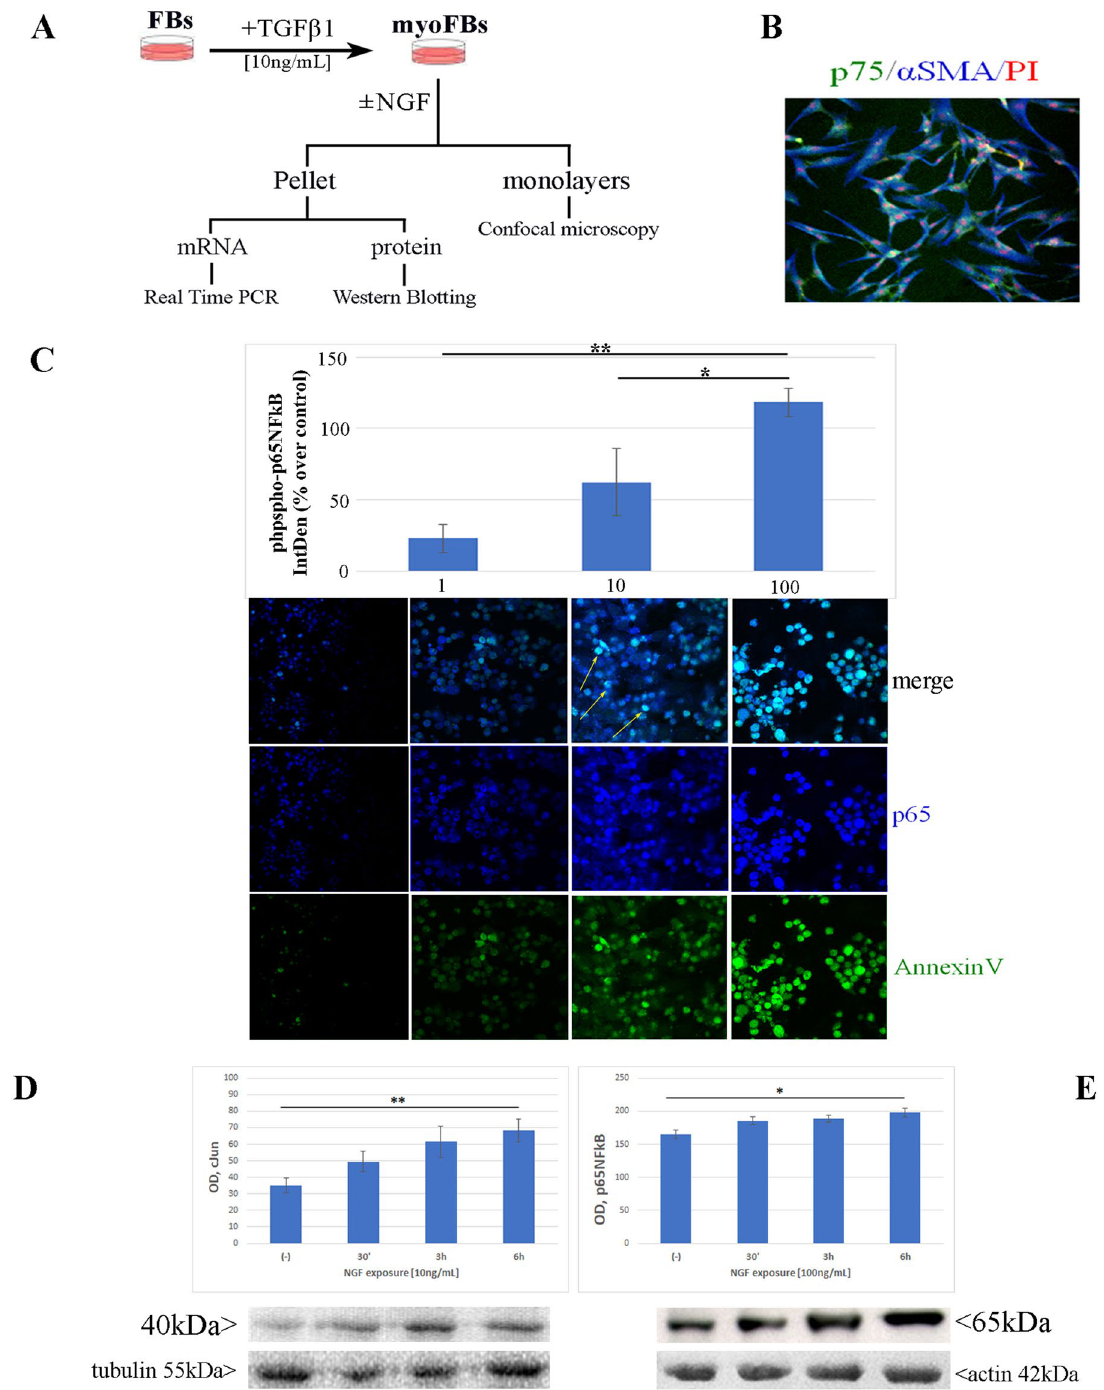
Figure 1. Overall experiment and cell features. ( A ) Flow chart summarizing the TGFβ1-induced myoFB and NGF exposures/ analysis. Stimuli and timing are highlighted. ( B ) Representative confocal microscopy image showing co-expression of p75 NTR (cy2/ green) and αSMA (cy5/blue) on nuclear stained myoFBs (Propidium Iodide/red) (magnification, × 200). ( C ) NGF triggers p65NFkB expression in AnnexinV positive myoFBs. Dose-dependent increase of total p65NFkB is shown over 24 h, as detected by quantitative Imaging analysis (IntDen) on single-channel p65NFkB (cy2/green) confocal images. Immunoreactivity for AnnexinV (cy2/green) and p65NFkB (cy5/blue) in myoFBs as shown in the overlay row and the single panels below reported, all with respect to NGF exposure concentrations. Arrows in 10 ng/mL NGF (merge) panel point at some coexpressing cells: NGF effect is detectable as soon as at 10 ng/ mL and significantly increase at 100 ng/mL doses. (DE) Time-dependent histograms and cropped blots, showing expression of cJun and p65NFkB,at the specific molecular weight for cJun (40 kDa; D ) and total p65NFkB (65 kDa; E ) above the related tubulin (55 kDa) and actin (42 kDa) housekeeping ones, from NGF exposed myoFBs over a timing of 30 min, 3 and 6 h. Densitometric analysis was performed specifically on the cropped image (see panel), resulting from the original immunoblot (see Fig. S1), to avoid any artefact in acquisition and data were expressed as compared to untreated ones. Minor brightness/contrast adjustment were performed by photoshop for better image presentation (cropped panel). ANOVA analysis followed by Tukey Kramer post-hoc; Sign: * p < .05; magnification, ×